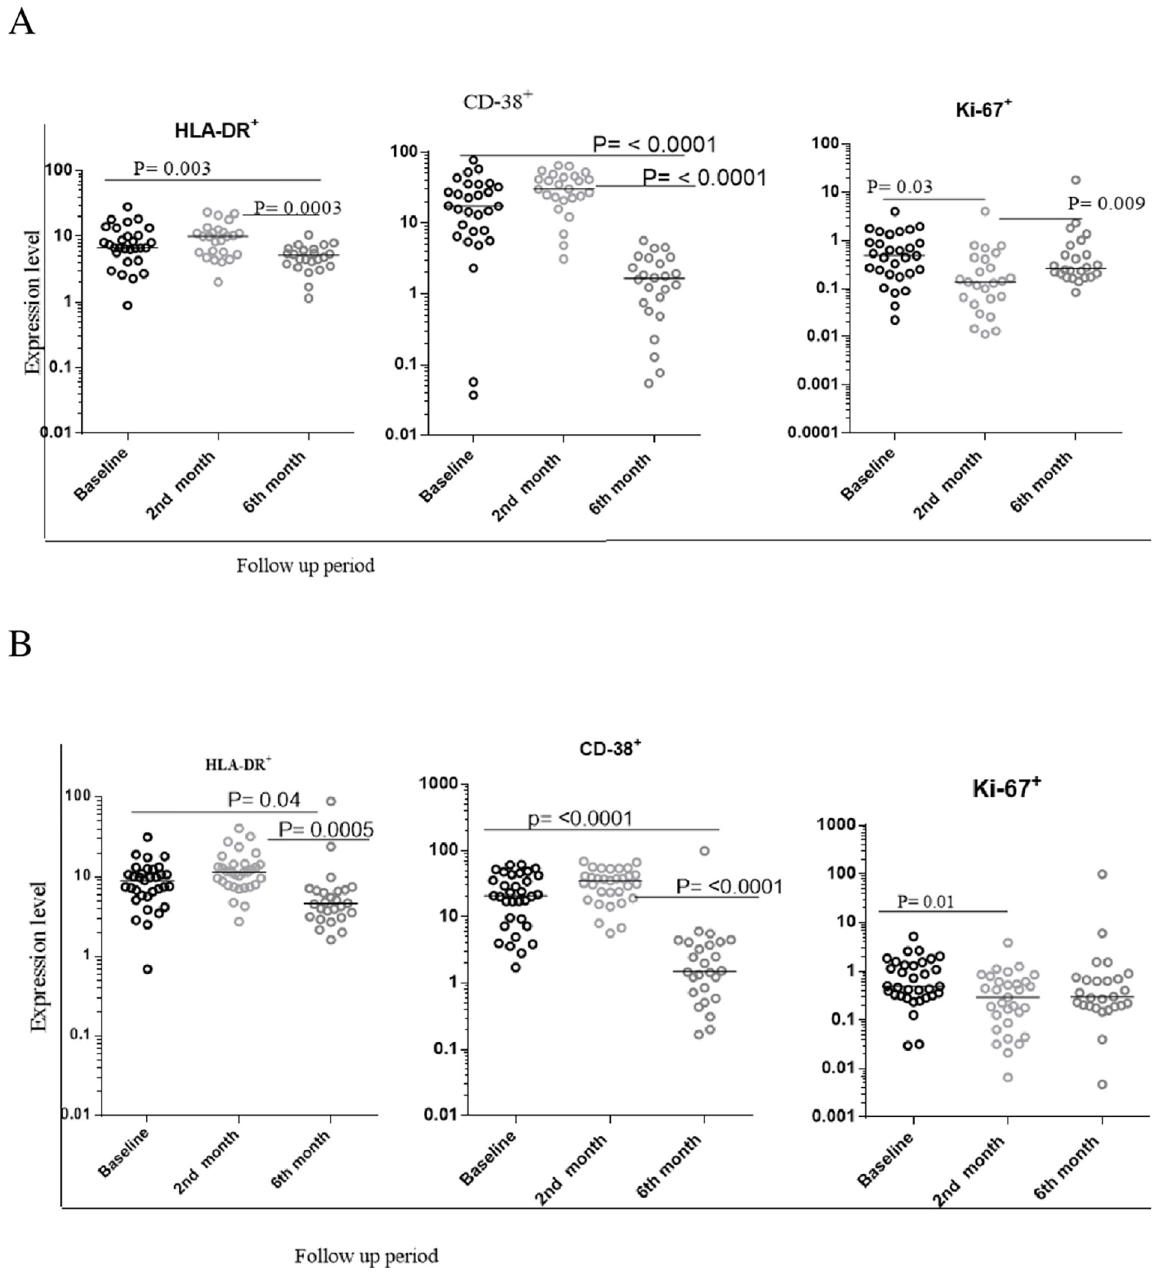
Fig 2. The level of IFN- γ + and TNF- α + responses from PPD specific CD4+ T cells during the standard anti-TB treatment follow up time period. A:—The level of IFN- γ + and TNF- α + responses among smear negative PTB patients. B:—The level of IFN- γ + and TNF- α + among smear positive PTB patients. Cytokine evaluation was performed after overnight stimulation with PPD or control cultures. The bars within each plot indicate the median value for each marker and time point. Data analysis was done using non-parametric Wilcoxon matched-paired rank test with significant p values indicated. Stimulation indices (SI) represent the ratio of frequencies in the presence of PPD to that of the absence of PPD. Baseline represents values prior to initiation of standard anti-TB drugs. 2 nd and 6 th month refers to time after therapy initiation.